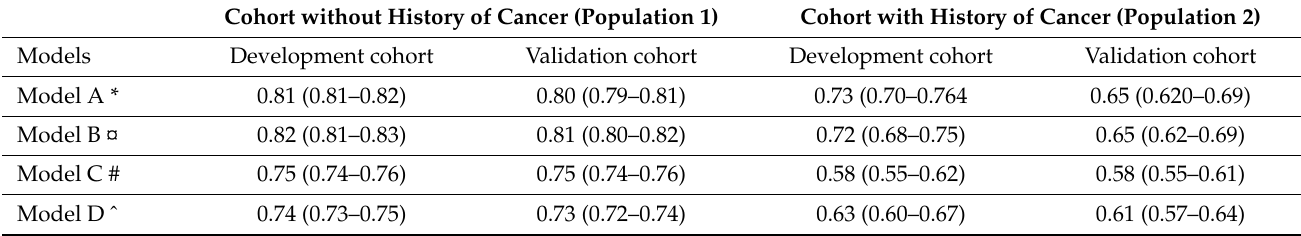
Table 2. Comparison of obtained AUC among different prediction models.